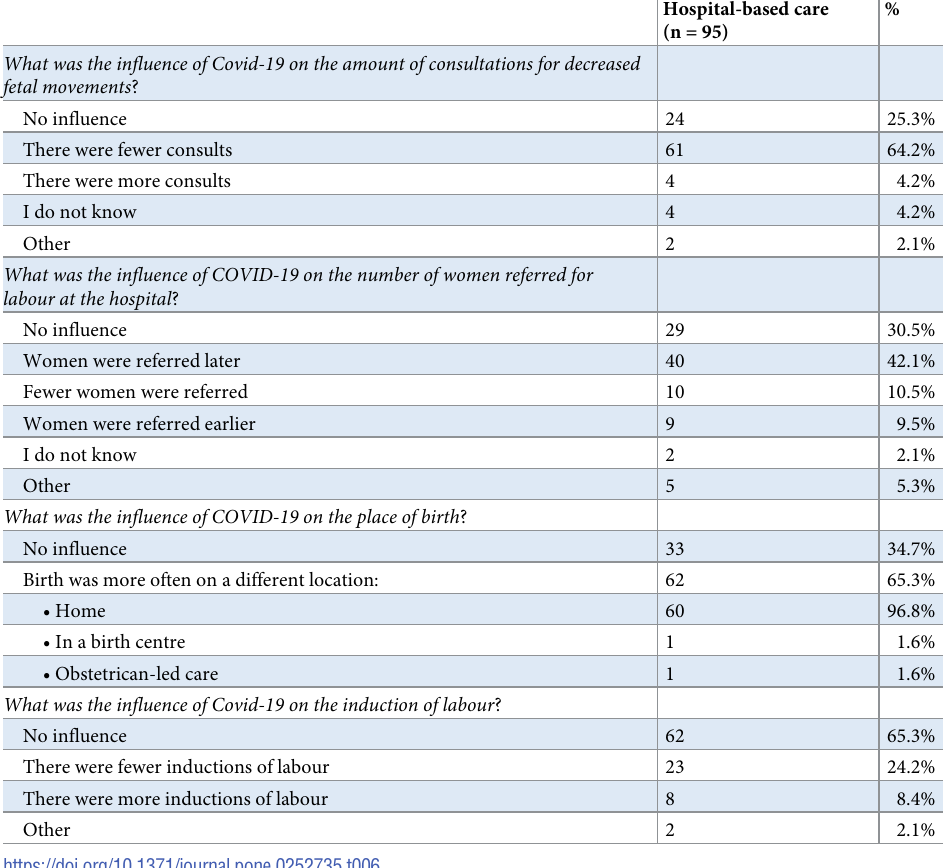
Hospital-based care % (n = 95)